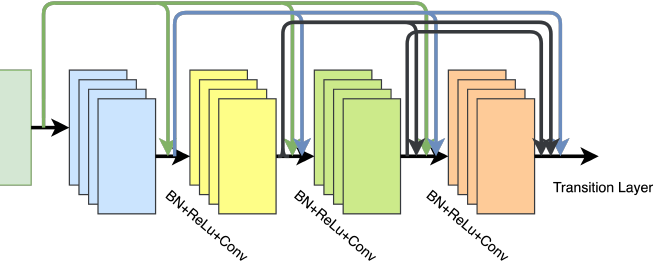
Figure 6. The main module of DenseNet showing the concatenation of features from previous